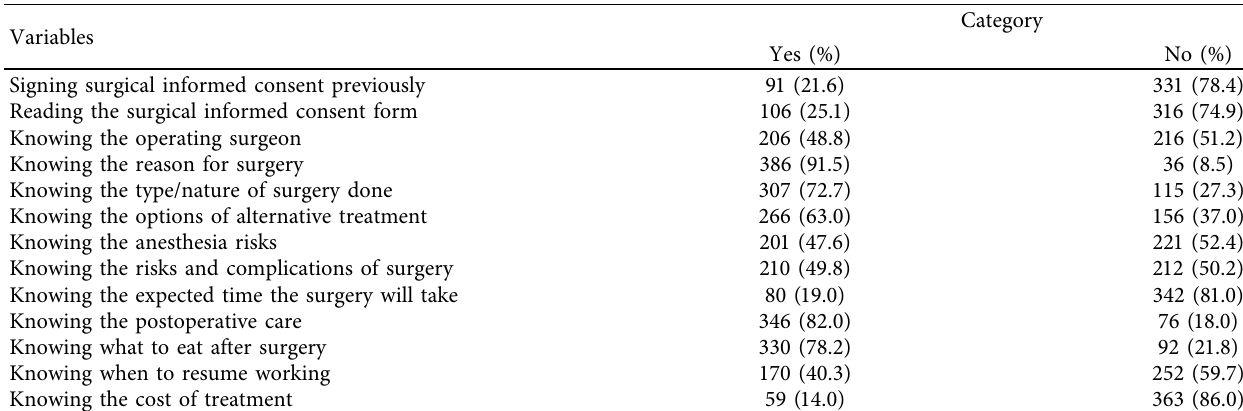
Table 5: Surgical patients’ knowledge and understanding of informed consent in Dessie City Administration public hospitals, Northeast Ethiopia, 2021 ( N �